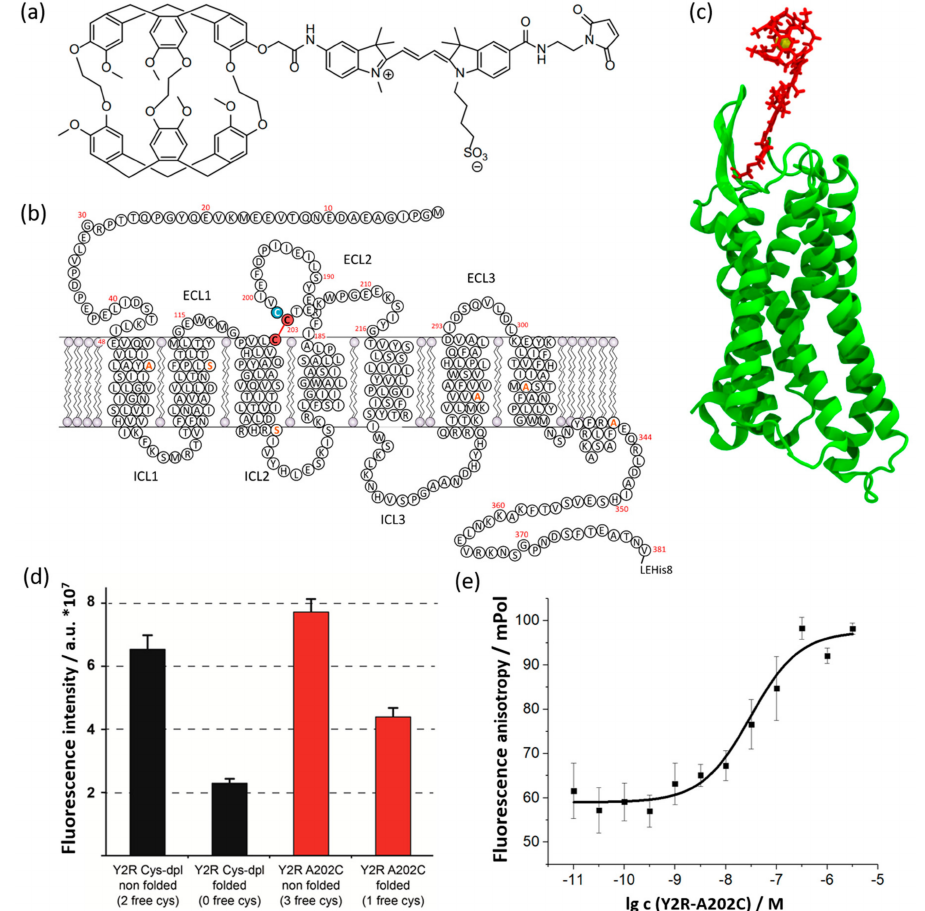
Figure 1. Representation of the Y2R-A202C-CrA construct. ( a ) Schematic chemical structure of CrA- Cy3-mal construct. ( b ) Sequence map of cytoplasmic Y2R-A202C. The cysteine introduced at